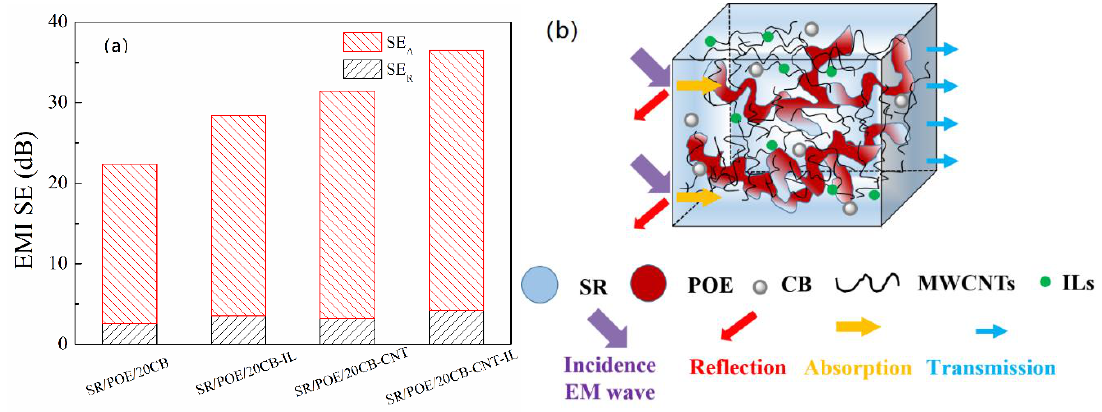
Figure 4. ( a ) Comparison of SE T , SE A , and SE R of the SR/POE/CB, SR/POE/CB-IL, SR/POE/CB-CNT-IL, and SR/POE/CB-CNT composites at 9.0 GHz, and ( b ) Schematic illustration of EMI shielding mechanisms for the SR/POE/CB-CNT-IL composites